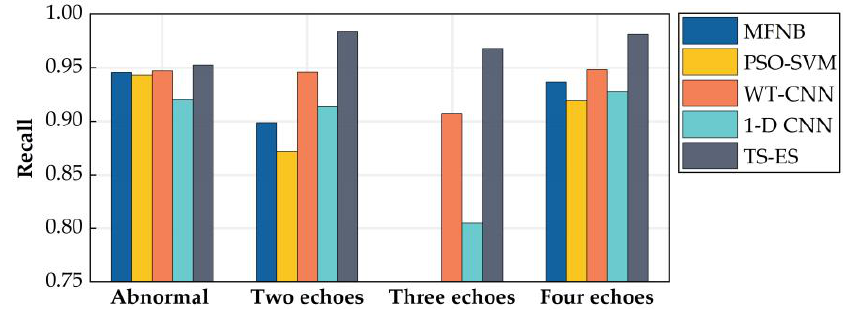
Figure 10. Recall of each method.